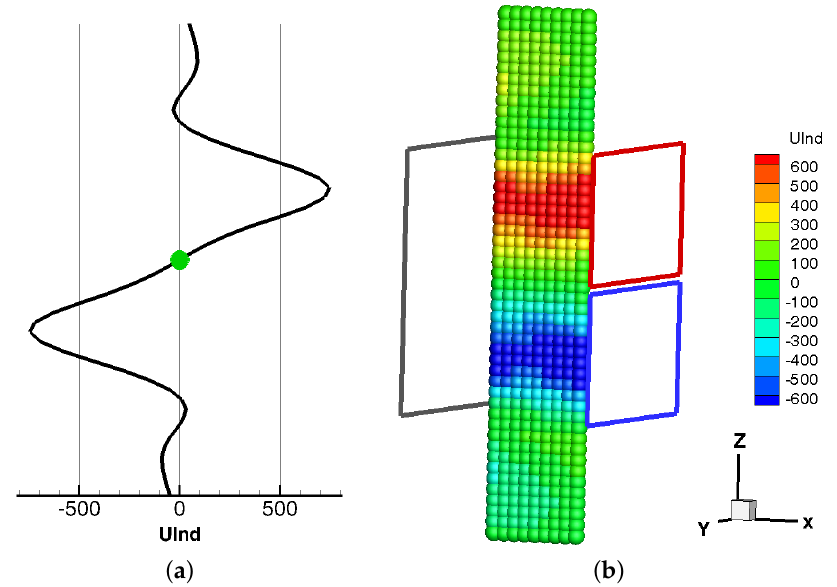
Figure 2. Induced voltage (UInd) of the 2D-model in arbitrary units for a bubble in the channel traveling over z. ( a ) The signal of the gradiometer for one bubble at the center of the channel; ( b ) The color of each bubble in the central plane of the sensor represents its induced voltage in the